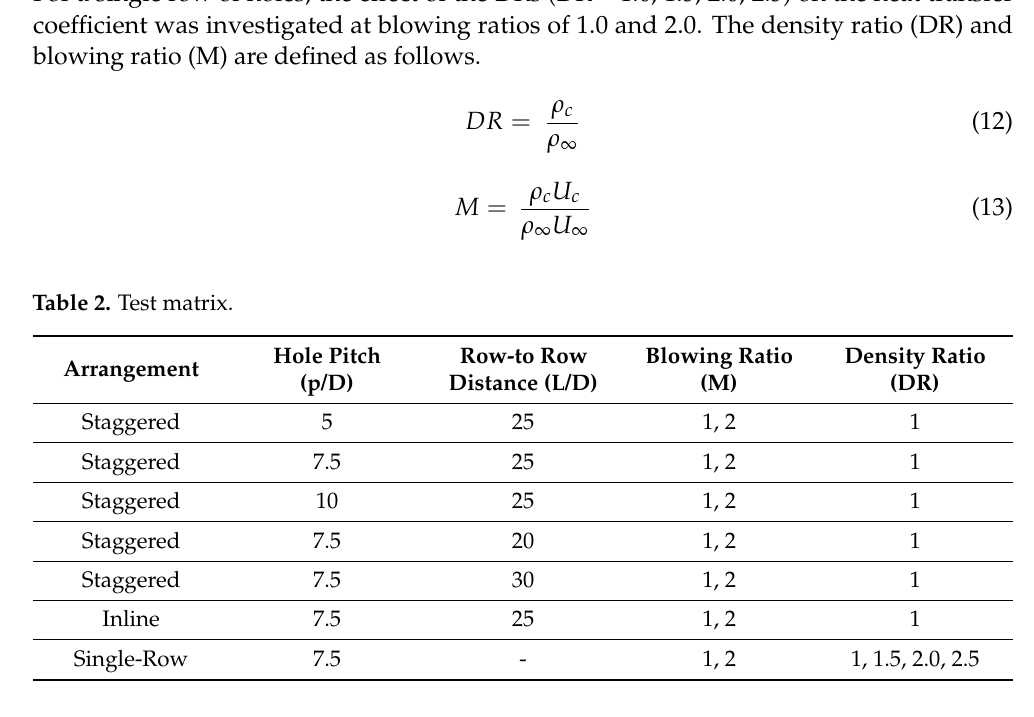
transfer measurement with three hole pitches (p/D = 5, 7.5, 10), three row-to-row distances (L/D = 20, 25, 30), and two arrangement methods (staggered and inline) were considered. For a single row of holes, the effect of the DRs (DR = 1.0, 1.5, 2.0, 2.5) on the heat transfer coefficient was investigated at blowing ratios of 1.0 and 2.0. The density ratio (DR) and blowing ratio (M) are defined as follows.